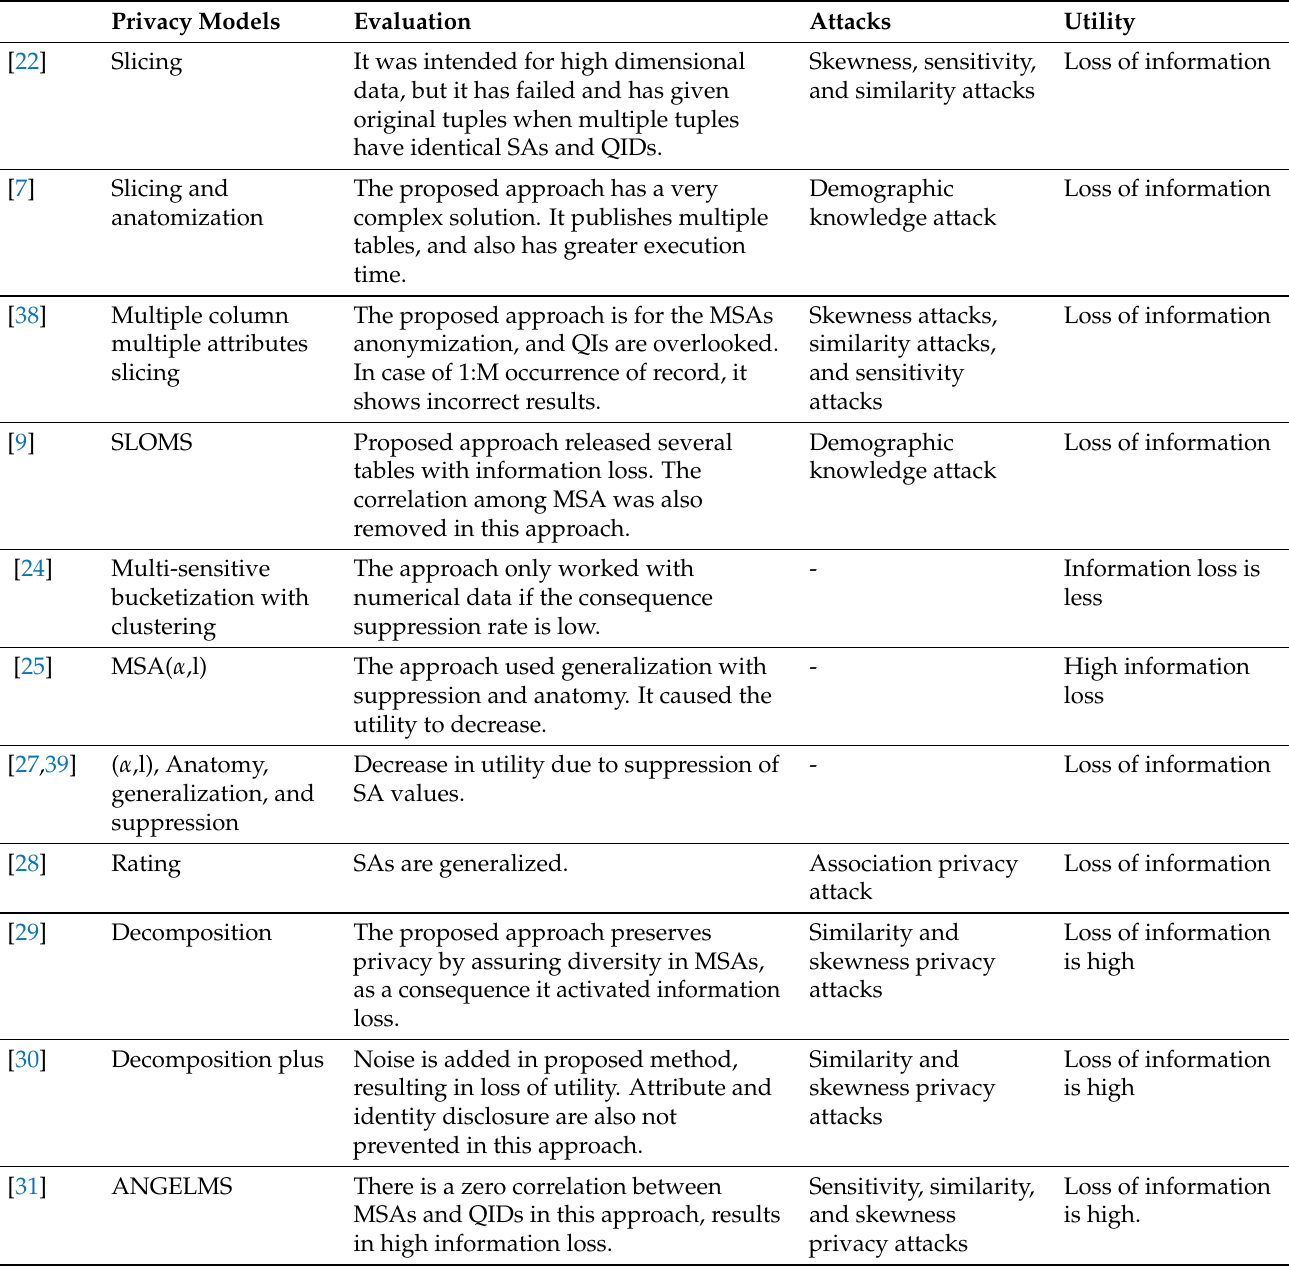
Table 5. Comparison of MSAs based